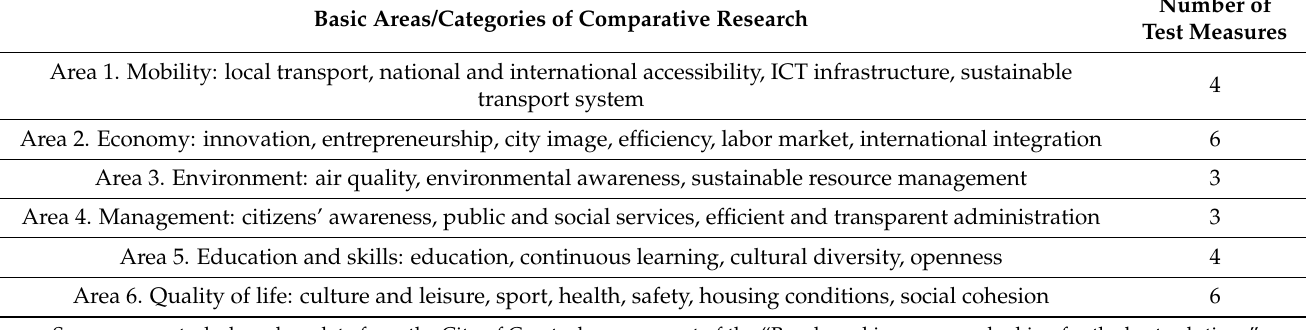
Table 1. Basic areas/categories of comparative research. Basic Areas/Categories of Comparative Research